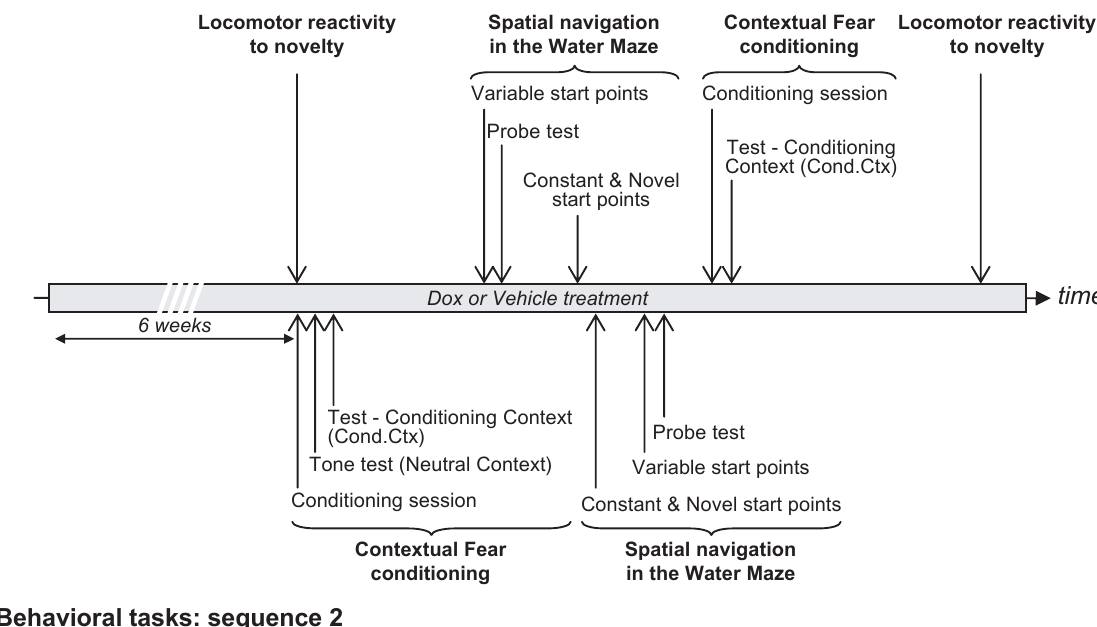
Figure 4. Diagram of behavioral task sequences.